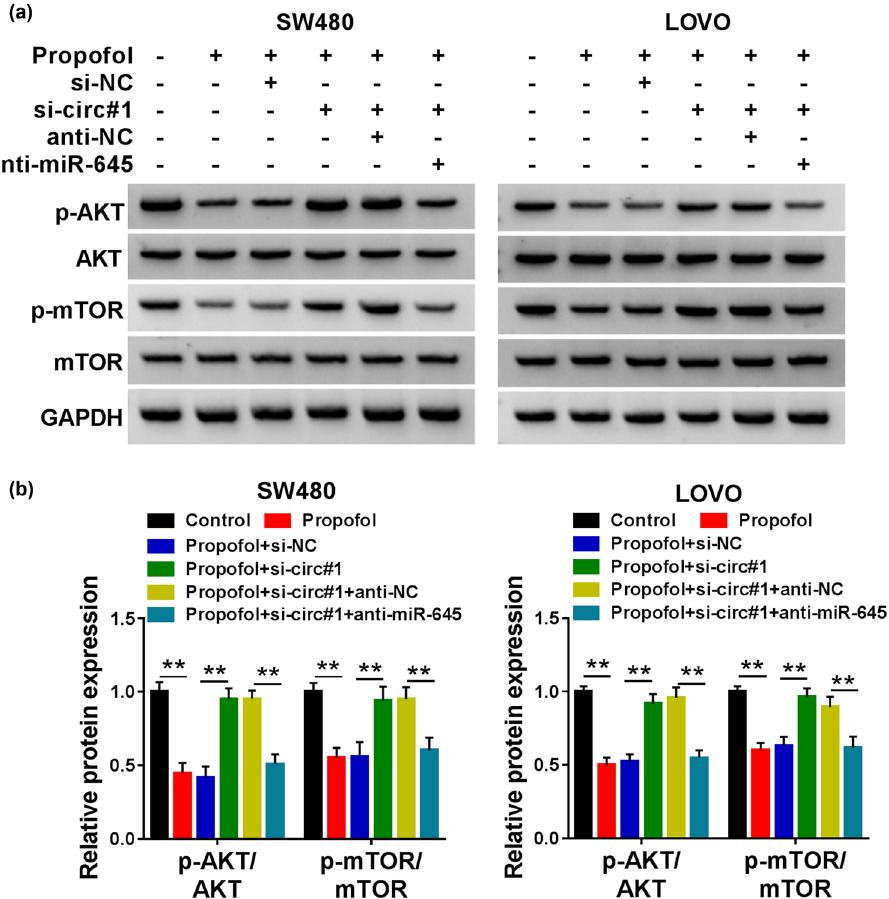
Figure 6: circ_0026344 silencing restrained propofol - inactivated Akt/mTOR pathway by interacting with miR - 645. ( a and b ) The e ff ects among propofol, circ_0026344 silencing, and miR - 645 inhibitor on Akt/mTOR pathway were presented by detecting the protein levels of p - AKT, AKT, p - mTOR, and mTOR by western blot in SW480 and LOVO cells. Signi fi cant di ff erences were compared with ANOVA. ** P <